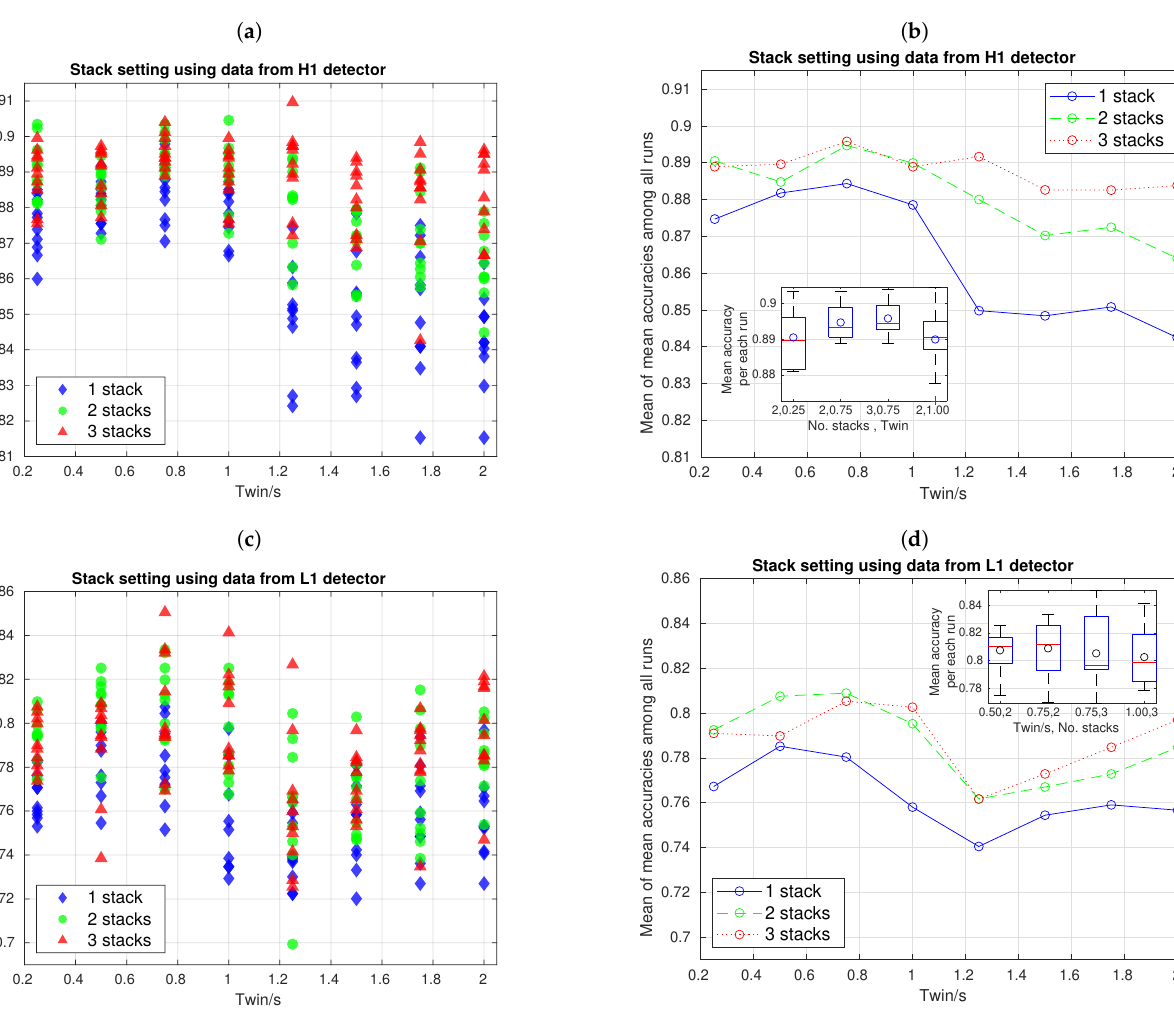
Figure 7. Hyperparameter adjustment to find best CNN architectures, i.e., number of stacks, and time resolution T win . Left panels, ( a , c ), show all samples of mean accuracies, and right panels, ( b , d ), the mean of mean accuracies among all runs; all in function of T win for 1, 2, and 3 stacks in the CNN. Besides, small boxplots are included inside right plots to have more clear information about dispersion and skewness of distribution of mean accuracies that are more relevant and from where we chose our optimal settings. Based on this, we concluded that T win = 0.75 s, with 3 stacks (H1 data) and with 2 stacks (L1 data), are optimal settings. We used 20 convolutional kernels, repeating a 10-fold CV experiment 10